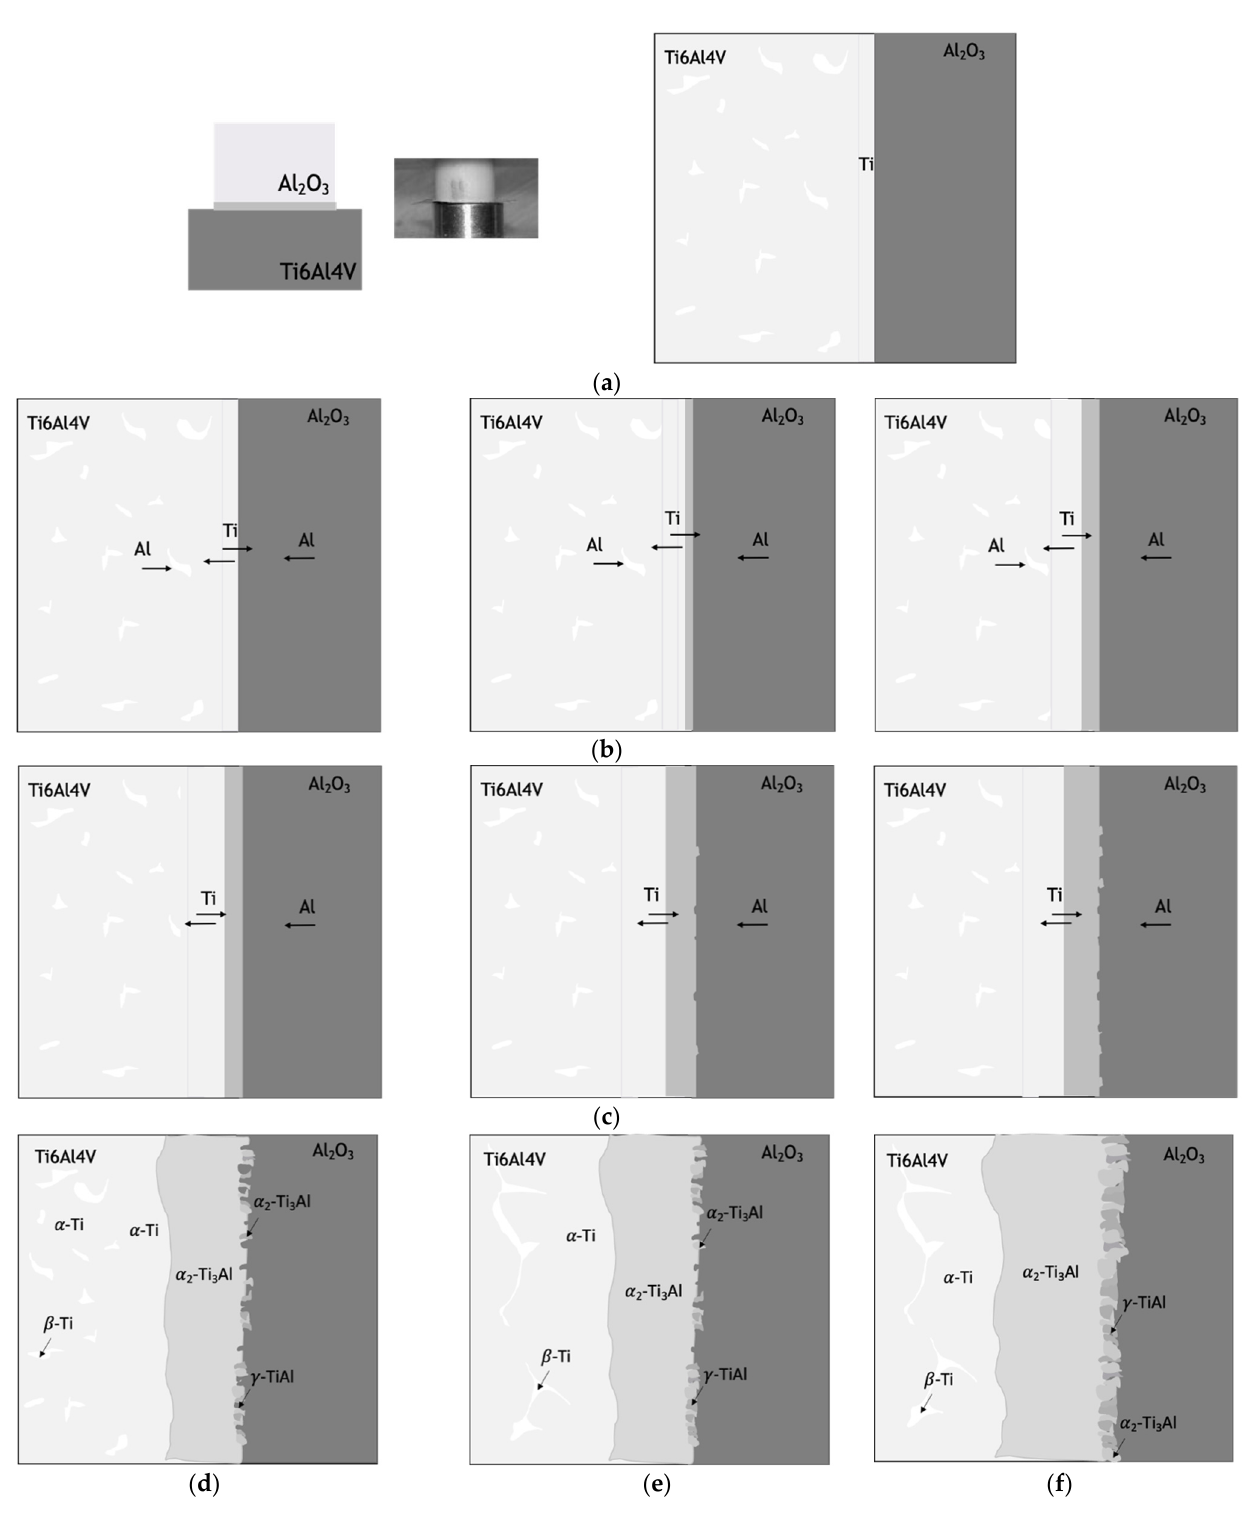
Figure 10. Microstructure evolution during the diffusion bonding of Ti6Al4V to Al 2 O 3 using Ti thin films: ( a ) initial microstructure, ( b ) sequence of the formation and growth of the α 2 -Ti 3 Al layer due to Ti and Al diffusion, ( c ) growth of α -Ti, formation of α 2 -Ti 3 Al layer and formation of α 2 -Ti 3 Al and γ -TiAl grains close to Al 2 O 3 base material, ( d ) microstructure of the interface formed at 950 °C for 60 min, ( e ) microstructure of the interface formed at 1000 °C for 10 min and ( f ) microstructure of the interface formed at 1000 °C for 60 min.